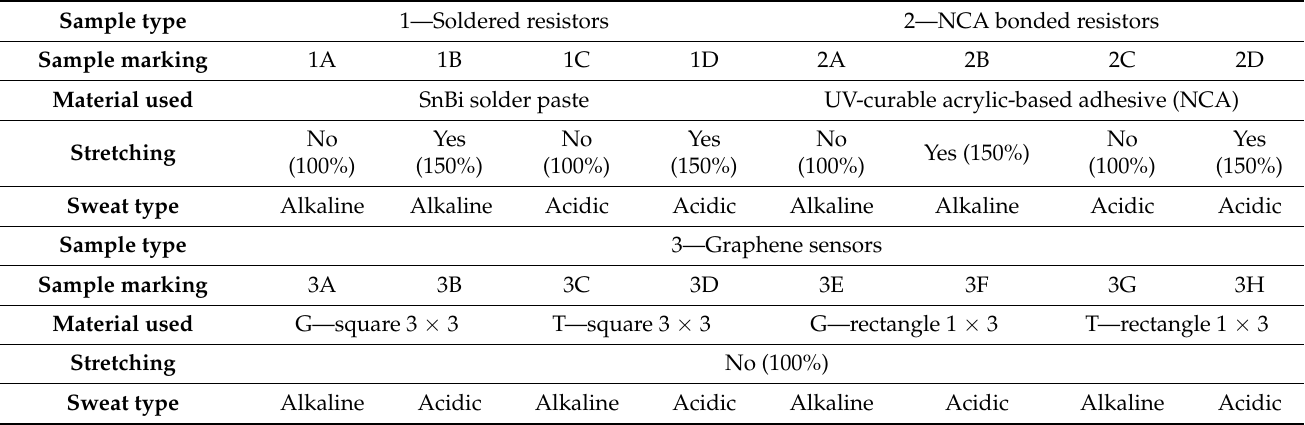
Table 1. Table of used sample types and sample labels.